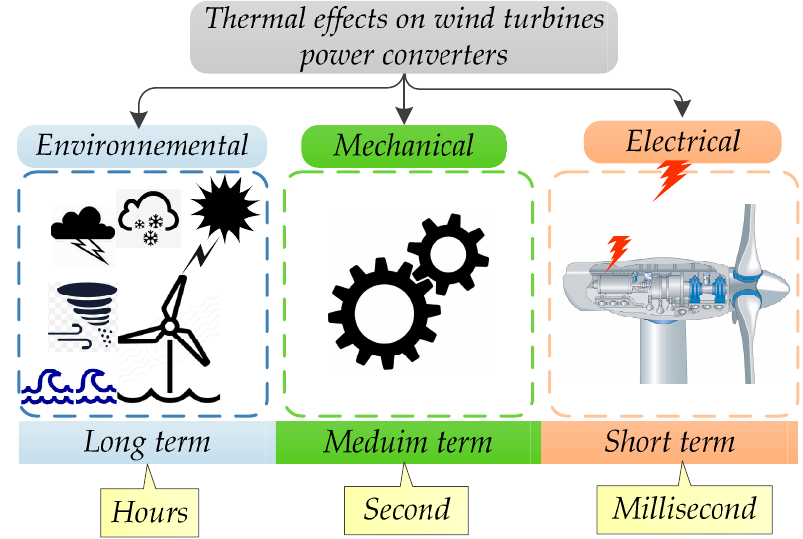
Figure 2. Wind power converter thermal cycles.